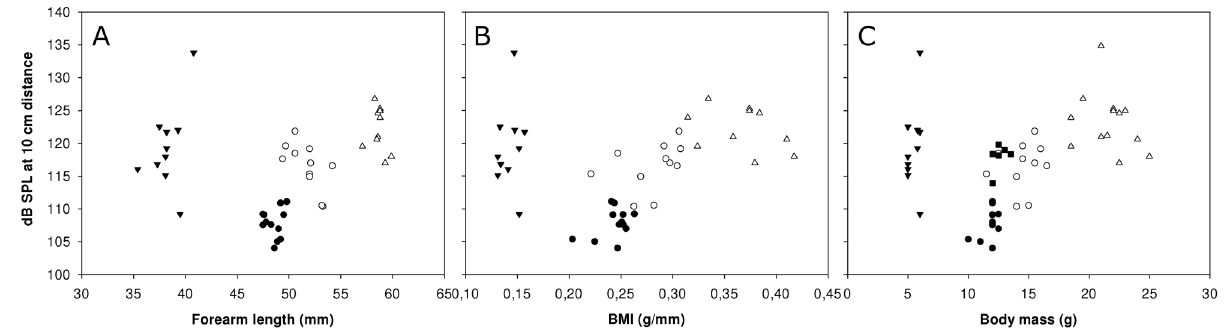
Figure 4. Intraspecific call intensity relations. Call intensities (in dB SPL; calculated for 10cm distance to the bats’ nose) for individual R. ferrumequinum (Rf, N=12), R. mehelyi (Rm, N=11), R. euryale (Re, N=12) and R. hipposideros (Rh, N=10) are plotted against A : forearm length (FA), B : body mass index (BMI) and C : body mass. For statistics, see text. (Rb only used for Fig. 3 because of missing body size data)